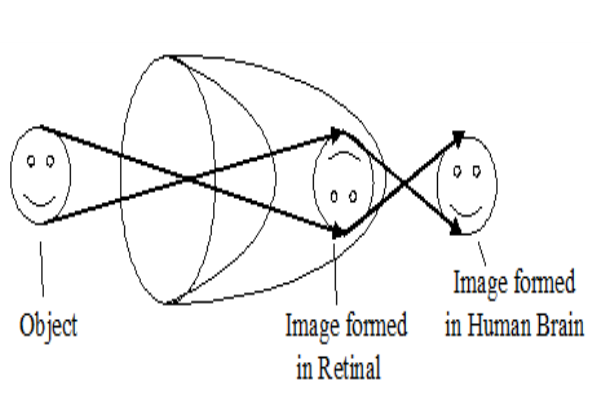
Figure 2. Eye Anatomy [24]